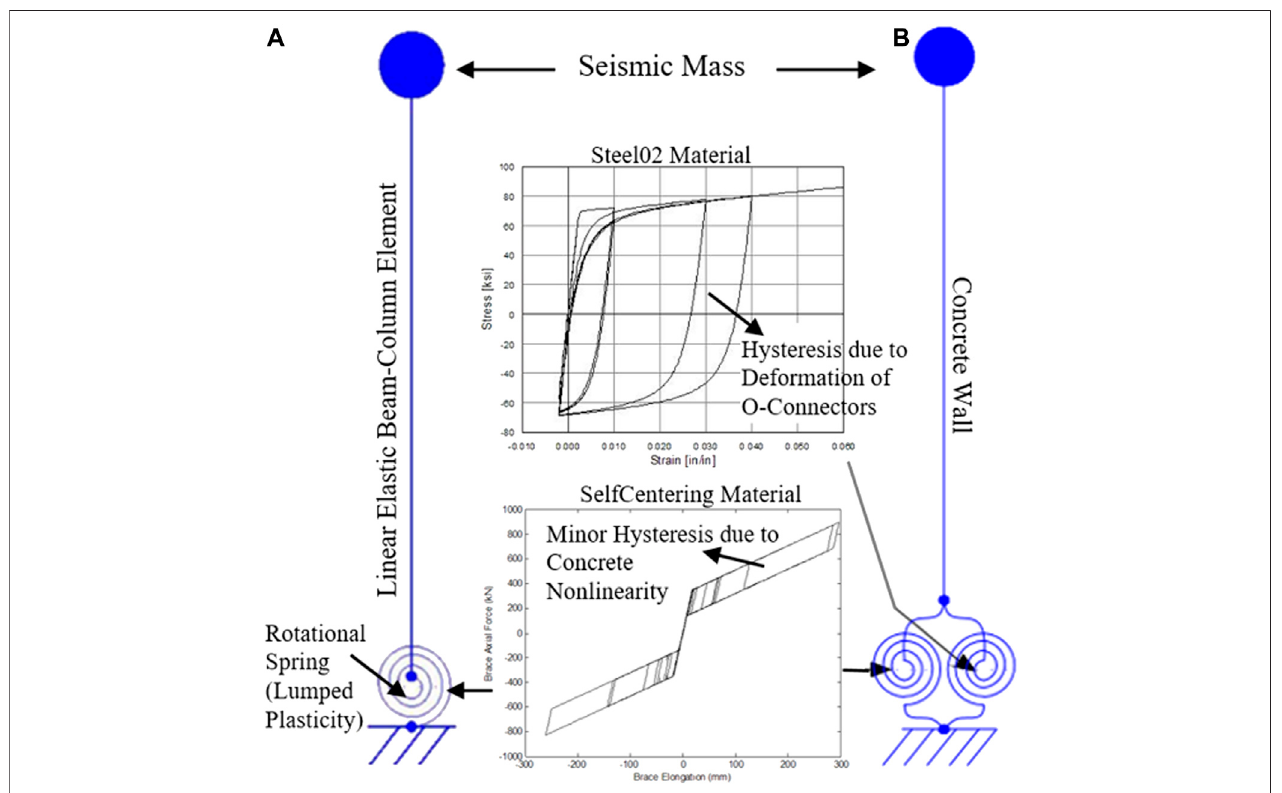
FIGURE 5 | Finite element model (FEM): (A) SRW; (B) PreWEC.